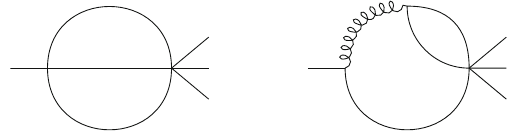
Fig. 6 2-Loop corrections to the quartic scalar vertex linear in the c coefficient where the dots represent c -independent terms and